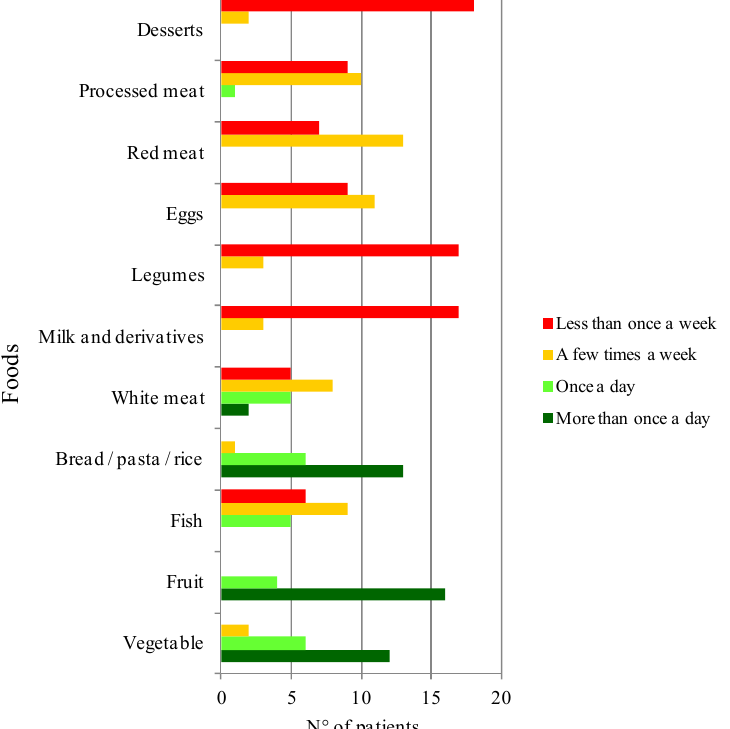
Figure 3. The frequency of consumption of foods during COVID-19 pandemic in the study group of patients with SNAS.